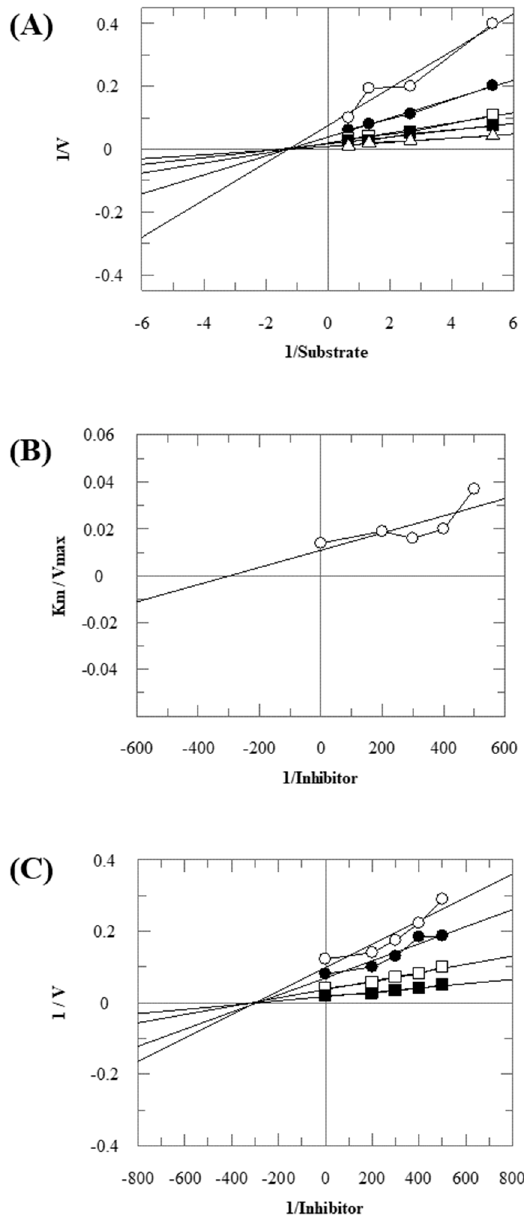
Figure 2. The inhibition of thymidine phosphorylase by compound 12 . ( A ) Lineweaver–Burk plot presented 1/V (velocities) on their Y-axis while that of reciprocal of the substrate (thymidine) on their X-axis. Order of the concentrations of inhibitor included in the absence of compound 12 ( ∆ ), in the presence of 200 µM ( ■ ), 300 µM ( □ ), 400 µM ( ● ), and 500 µM ( ○ ) of compound 12 . ( B ) The secondary replot of Lineweaver–Burk was plotted between the slopes (Km/Vmax) on Y-axis and 1/Inhibitor on X-axis, and ( C ) Dixon plot presented 1/V on Y-axis, while 1/Inhibitor on X-axis.